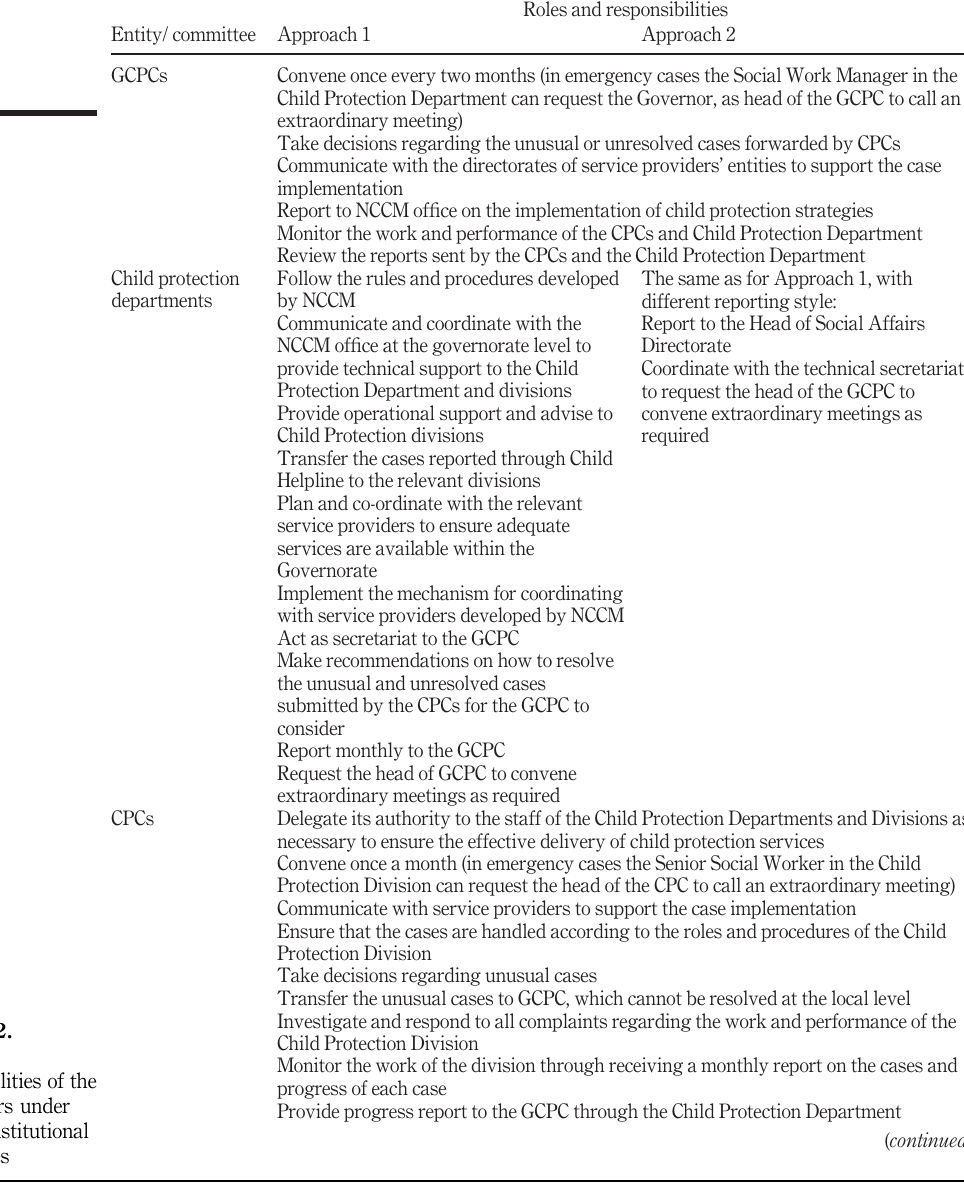
Table A2. Roles and responsibilities of the key players under the two institutional